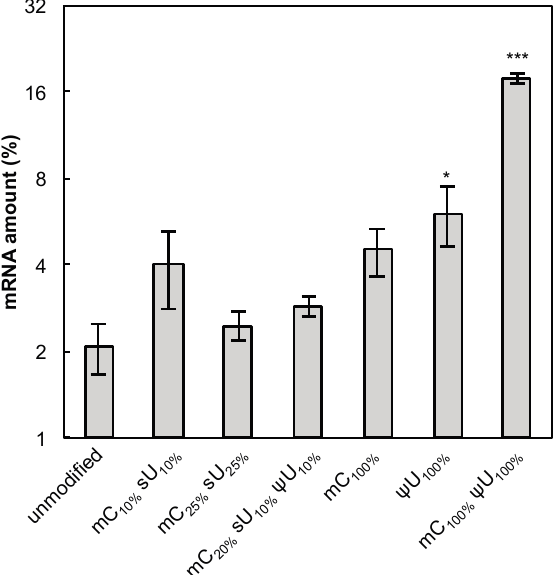
Figure 7. Nuclease stability of mRNA. mRNA-encoding GLuc in a naked form was incubated in 0.05% serum at 37 °C for 15 min. qRT-PCR measurement was performed to quantify the amount of mRNA that has an intact sequence between a chosen primer pair. The amount of mRNA after serum incubation was compared to that before serum incubation and the relative values are shown in the graph. Data are presented as the mean ± standard error of the mean (S.E.M.) ( N = 4). Statistical significance was assessed by one-way analysis of variance (ANOVA) followed by Dunnett’s test. * p < 0.05, *** p < 0.001 versus unmodified